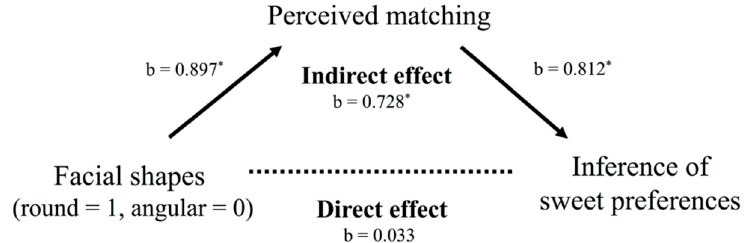
Figure 4. Model to predict the effect of facial shapes on inference of sweet preference mediated by perceived matching. Standardized coefficients (b) are displayed. Asterisks indicate significant paths ( p < 0.05 *).